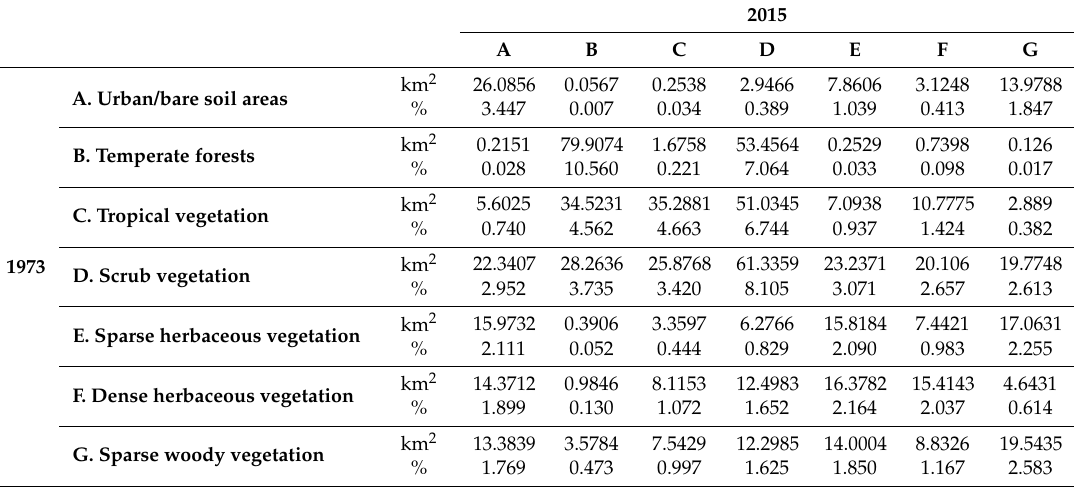
Table 18. Matrix of land use-cover changes from 1973 to 2015, in the adjacent area of Natural Protected Area Altas Cumbres (NPAAC). Victoria, Tamaulipas,